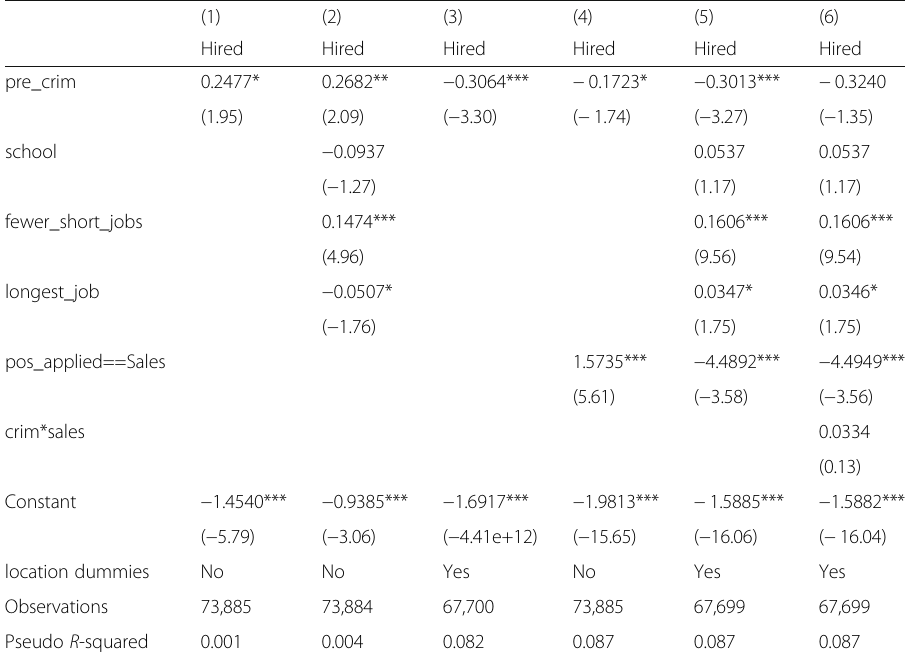
Table 15 Correlates of hiring rates, logit specification (customer service and